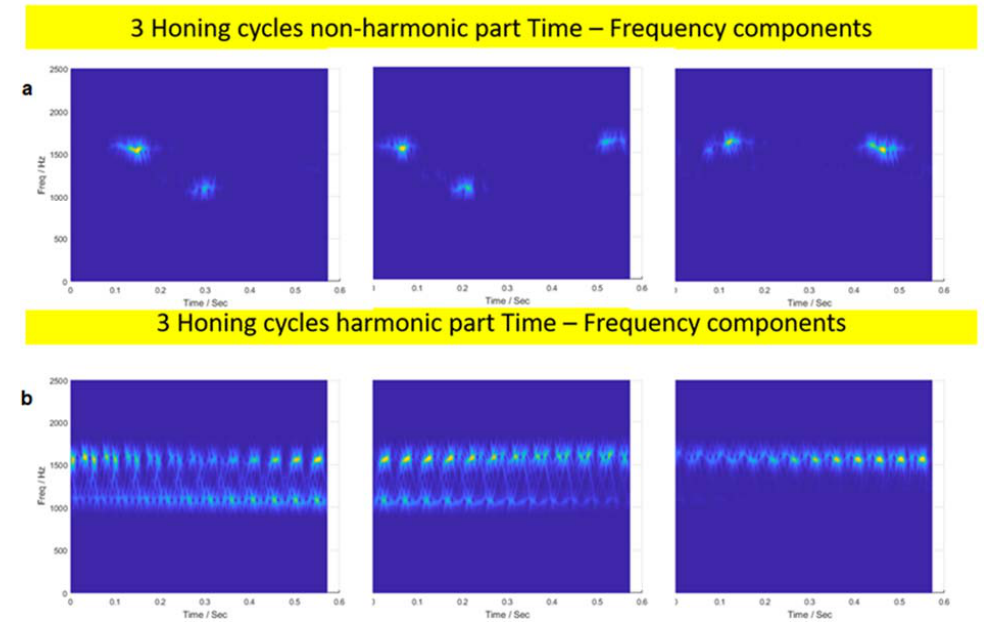
Figure 10. Chirplet time-frequency representation for 3 honing cycles of experiment 7: ( a ) Non-harmonic part, ( b ) harmonic part.